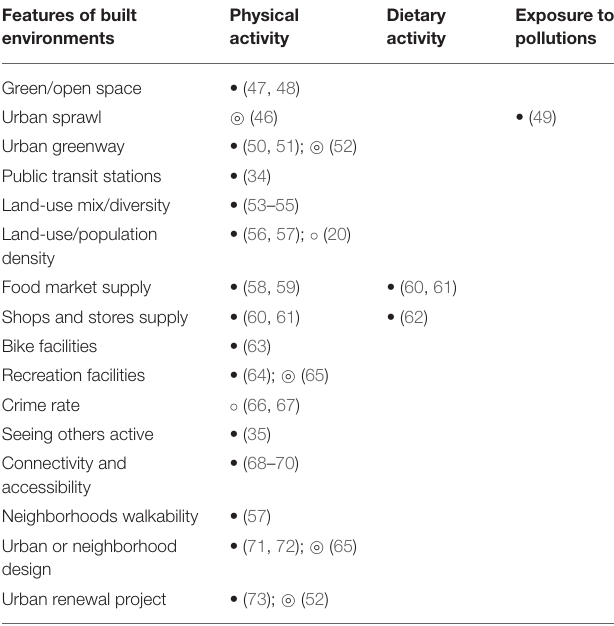
TABLE 2 | Measure and method of the built environment and public health. Classification